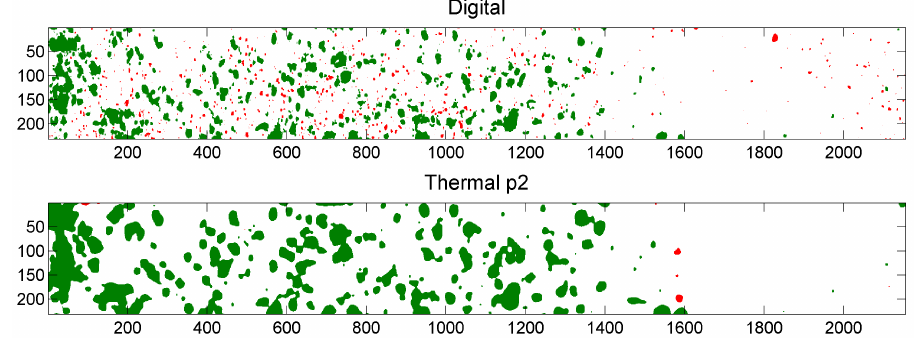
Figure 6. Binarized digital image ( top ); and binarized thermal output image “p 2 ” ( bottom ). Coordinates are shown in pixels. Particles that occur in both images are shown in green. Particles that occur only in the digital image or only in the thermal output image are shown in red in respectively the top image and the bottom image.